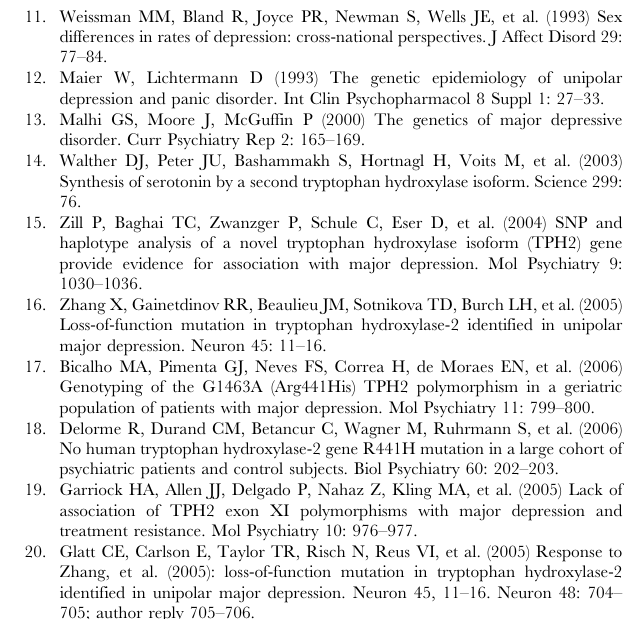
Table S2 Meta-analyses of genetic association studies of TPH2 gene polymorphisms and major